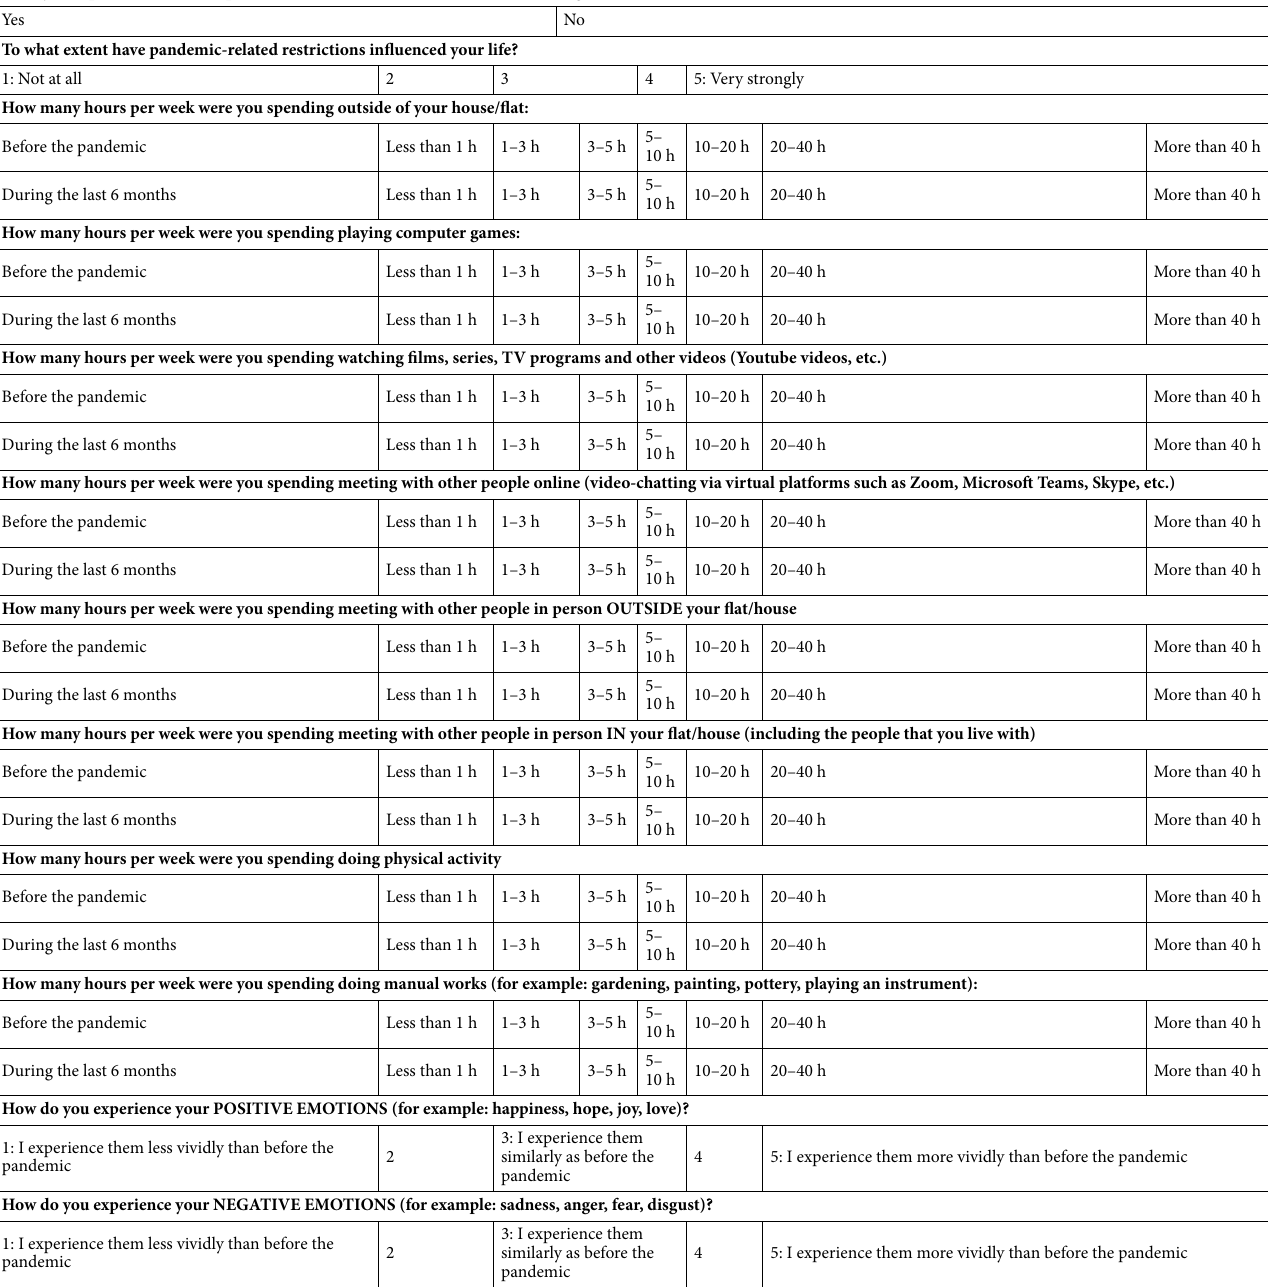
Table 4. Questionnaire measuring lifestyle habits before and during the